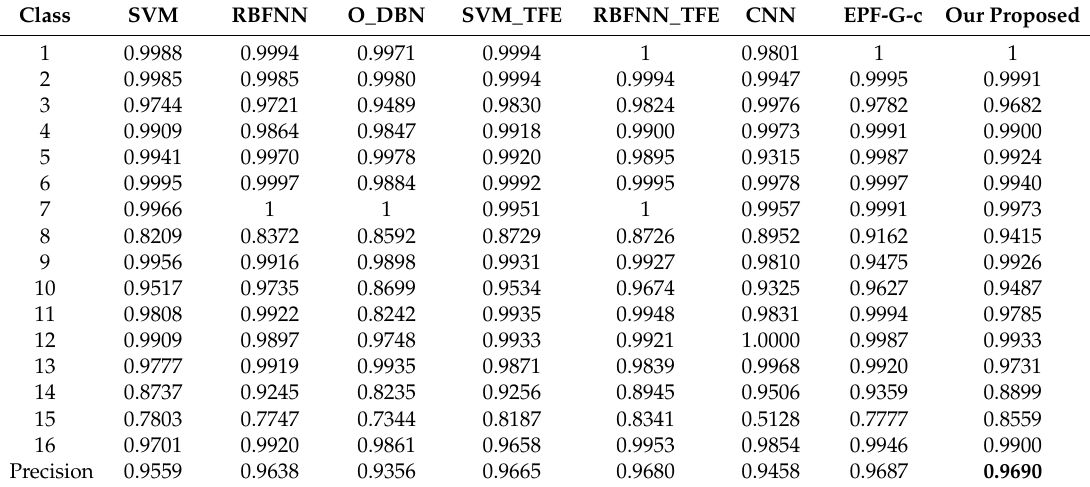
Table 11. Classification precision of different algorithms on Salinas